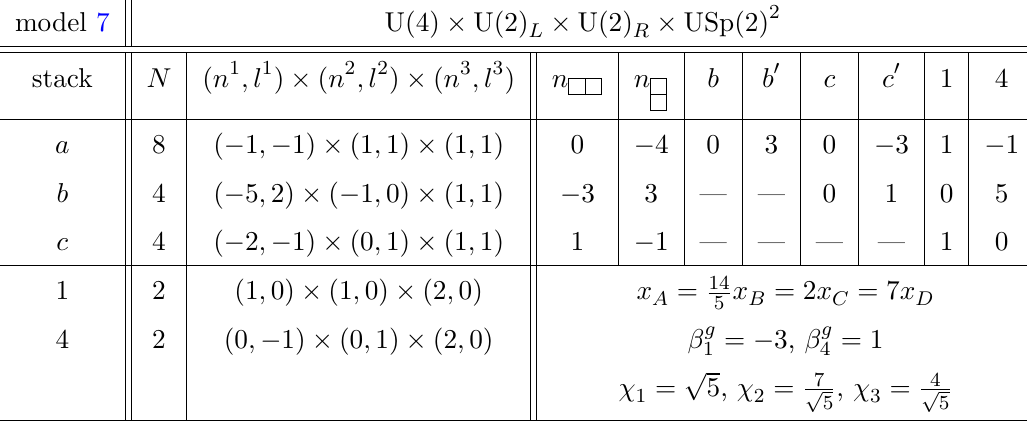
Table 7 . D6-brane configurations and intersection numbers of Model 7, and its MSSM gauge